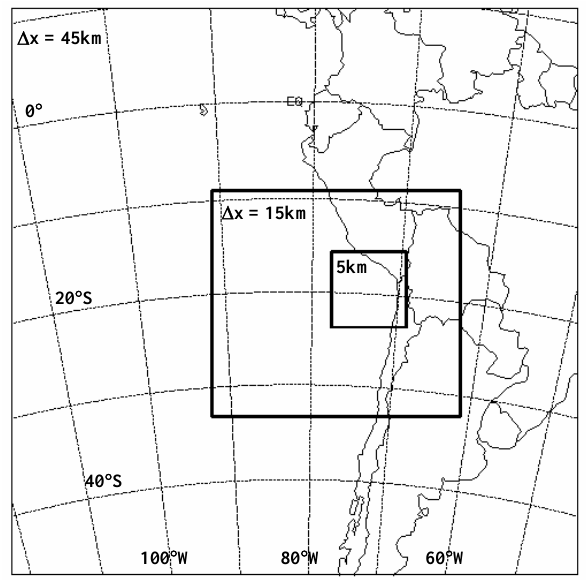
Fig. 1. COAMPS forecast domains for the VOCALS-REx. Three grid meshes (45 km, 15 km, 5 km) have 151 × 151, 199 × 188, and 151 × 151 grid points, respectively.